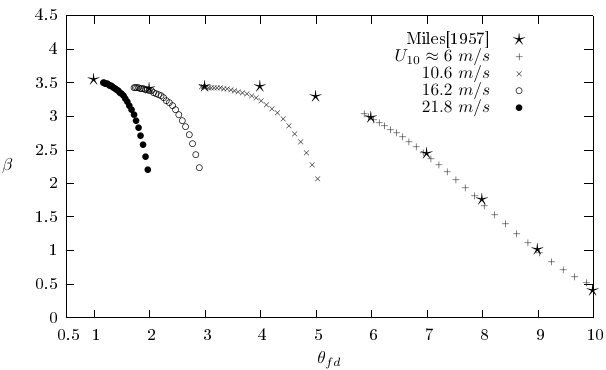
Fig. 3. β vs. θ fd , the wave-age-like parameter. The water depth is h = 3m for all curves above. For this depth, all 10m wind speeds account for early drops in the growth rate. The deep-water limit kh → ∞ , originally computed by Miles, is plotted for comparison. For the lower wind speed, the growth drop occurs closer to deep water. Although U 10 = 6ms − 1 gives a deep-water-like behaviour, we see that stronger winds imply early (wavelength-wise) drops in the growth rate.